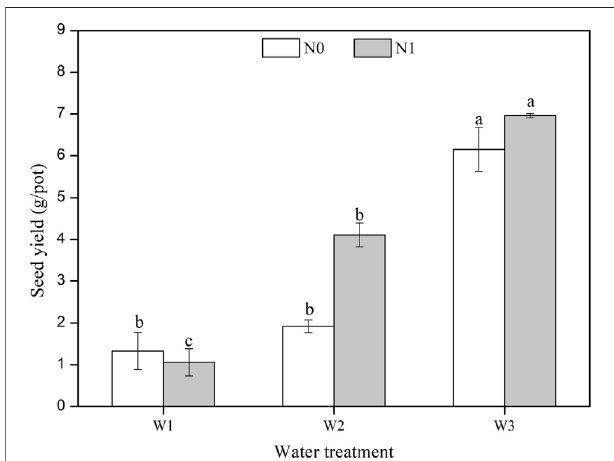
FIGURE 2 | Effects of water and nitrogen on seed yield of L. chinensis (mean ± SE).N 0 ,control,withoutNapplication;N 1 ,Nappliedasureaat10.5 g N/m 2 ; W 1 , 50% mean annual precipitation (249 mm) (irrigation amount: 96 ml per pot); W 2 , mean annual precipitation (498 mm) (irrigation amount: 193 mlper pot);andW 3 ,150%meanannualprecipitation (747 mm)(irrigation amount: 289 ml per pot). Different lowercase letters indicate signi fi cant differences ( p < 0.05) among water treatments at the same level of N addition.